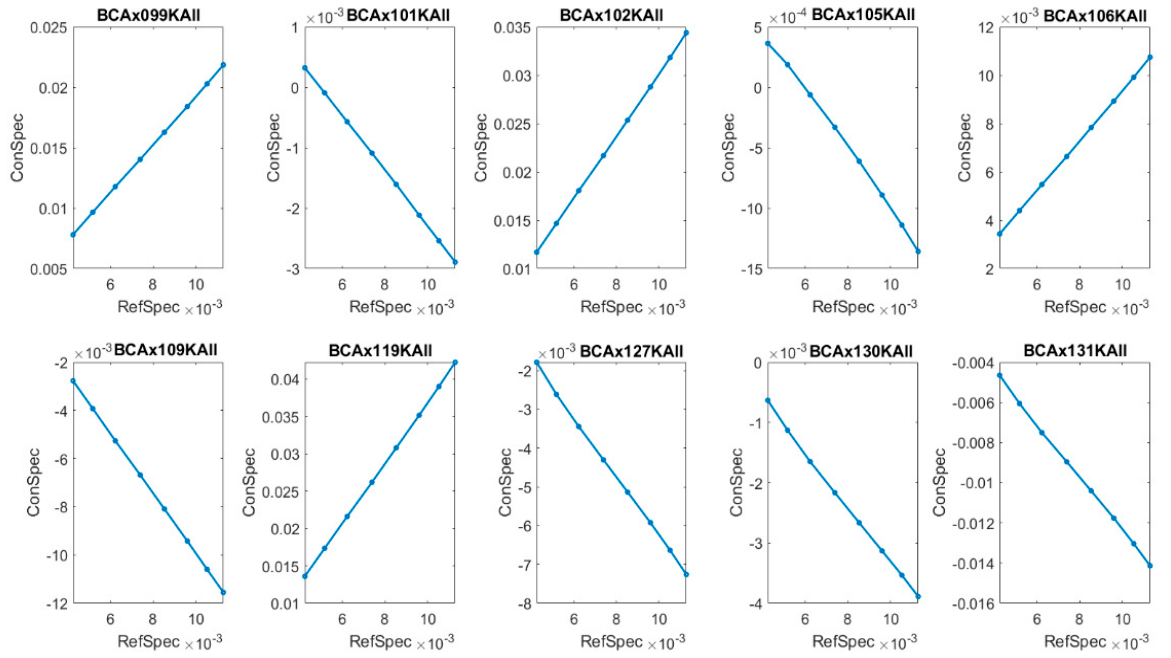
Figure 6. Lissajous curve for (RefSpec(k), ConSpec(k)), k ∈ ( 1042, 1050 ) [cm − 1 ]) for the control group. The phase shift between IR spectra of patients: BCAx099KALL, BCAx102KALL, BCAx106KALL, BCAx119KALL, and reference IR spectra RefSpec is equal to zero, whereas for the remaining patients it is equal to π .